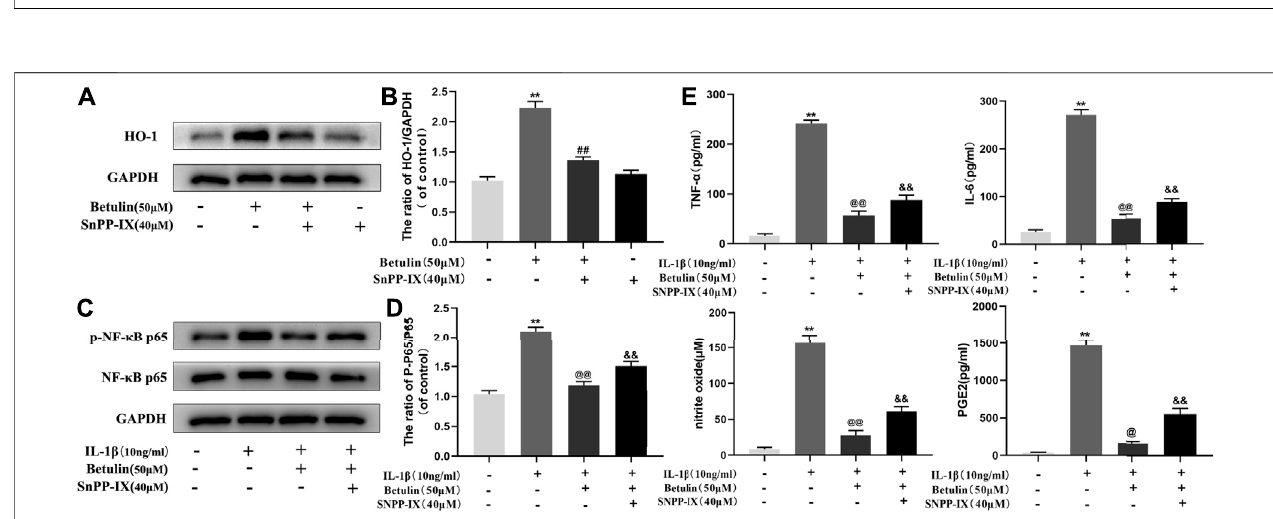
FIGURE 8 | Betulin inhibits the activation of the NF- κ B pathway and the generation of pro-in fl ammatory mediators through the HO-1 pathway. The chondrocytes were pretreated with HO-1 inhibitor SnPP-IX (40 μ M) for 2 h and treated with betulin (50 μ M) for 2 h. (A – D) The protein levels of p-p65 and HO-1 were detected by Westernblottingandquantitativelyanalyzed. (E) TheproteinlevelsofTNF- α ,IL-6,andPGE2weremeasuredbythecommercialELISAkitsandthegenerationofNOwas measuredbyGriessreaction.Thedatainthe fi gureshowthattheaveragevalueis ± SD,** p < 0.01compared withthecontrolgroup, ## p < 0.01compared withthe Betulin-treated group, && p < 0.01 compared with the Betulin + IL-1 β – treated group, @ p < 0.05, @@ p < 0.01 compared with the IL-1 β group, n (cid:2) 3.